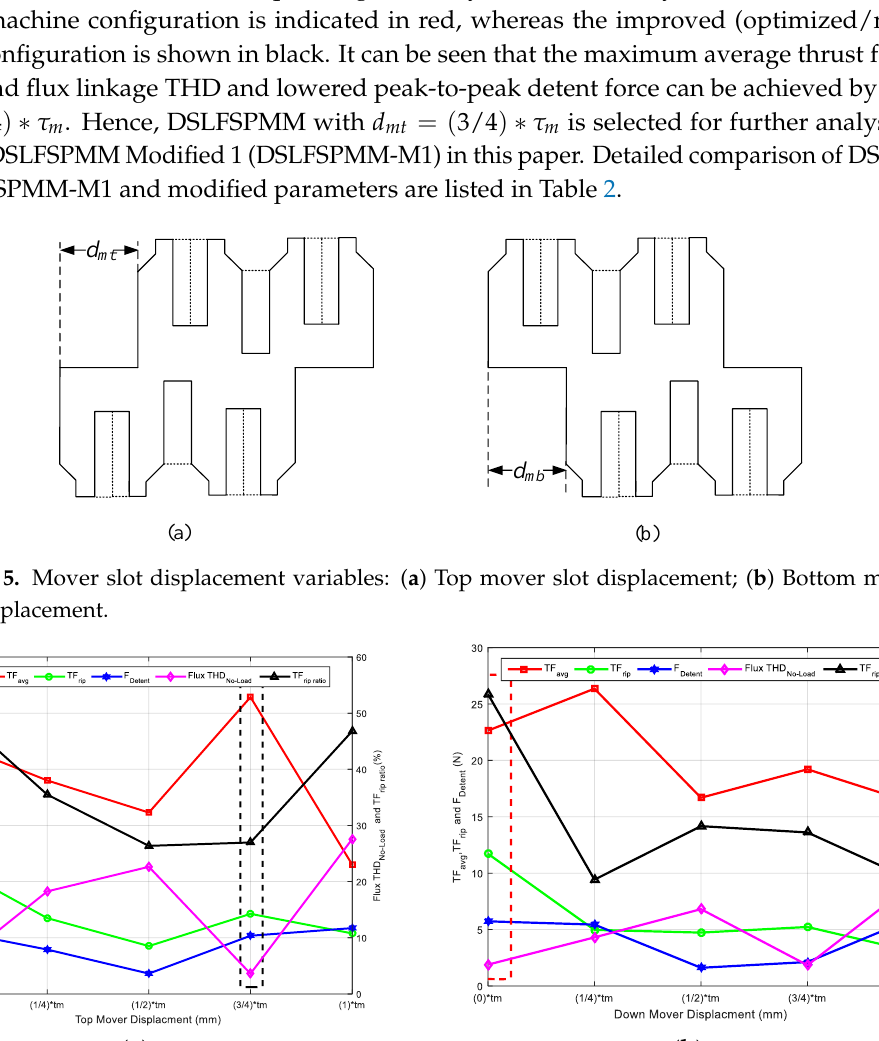
Figure 6. Mover slot displacement results: ( a ) Comparison of displaced top mover slot designs with initial design; ( b ) Comparison of displaced bottom mover slot designs with initial design. Table 2. Modified parameters and performance comparison of DSLFSPMM with DSLFSPMM-M1. Parameter (Unit)